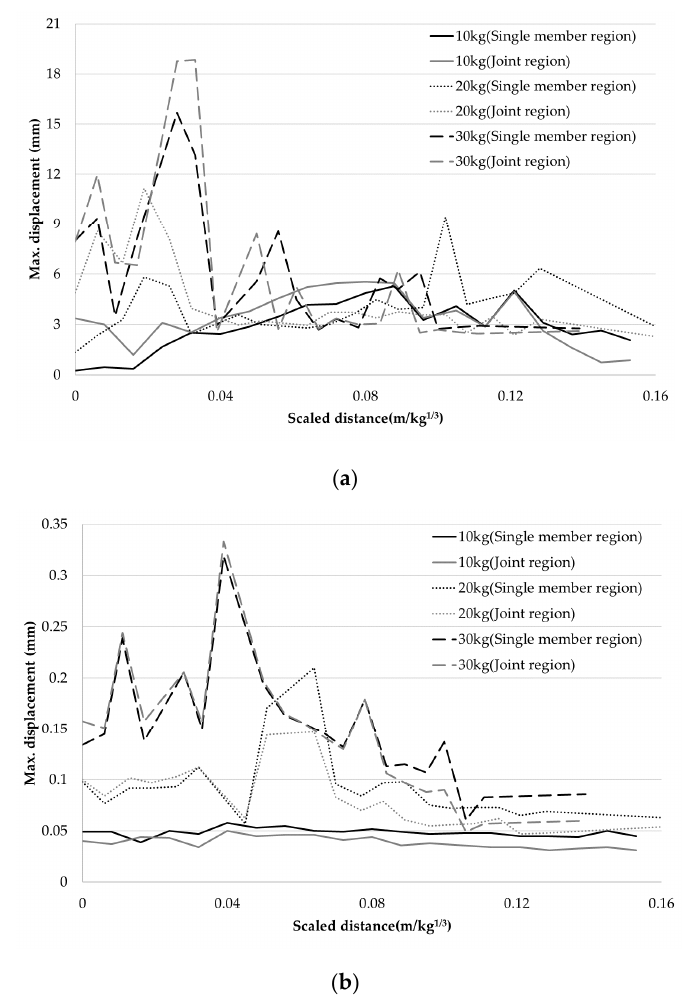
Figure 4. Maximum displacement of slab and column; ( a ) Slab; ( b ) Column